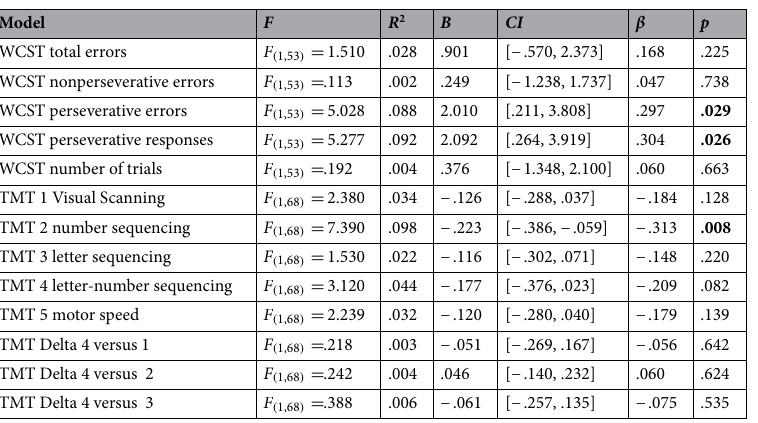
Table 2. Results of linear regression models predicting standardized neuropsychological scores by HIP scores. HIP Hypnotic Induction Profile, TMT Trail Making Test, from the Delis–Kaplan Executive Functioning System, WCST Wisconsin Card Sorting